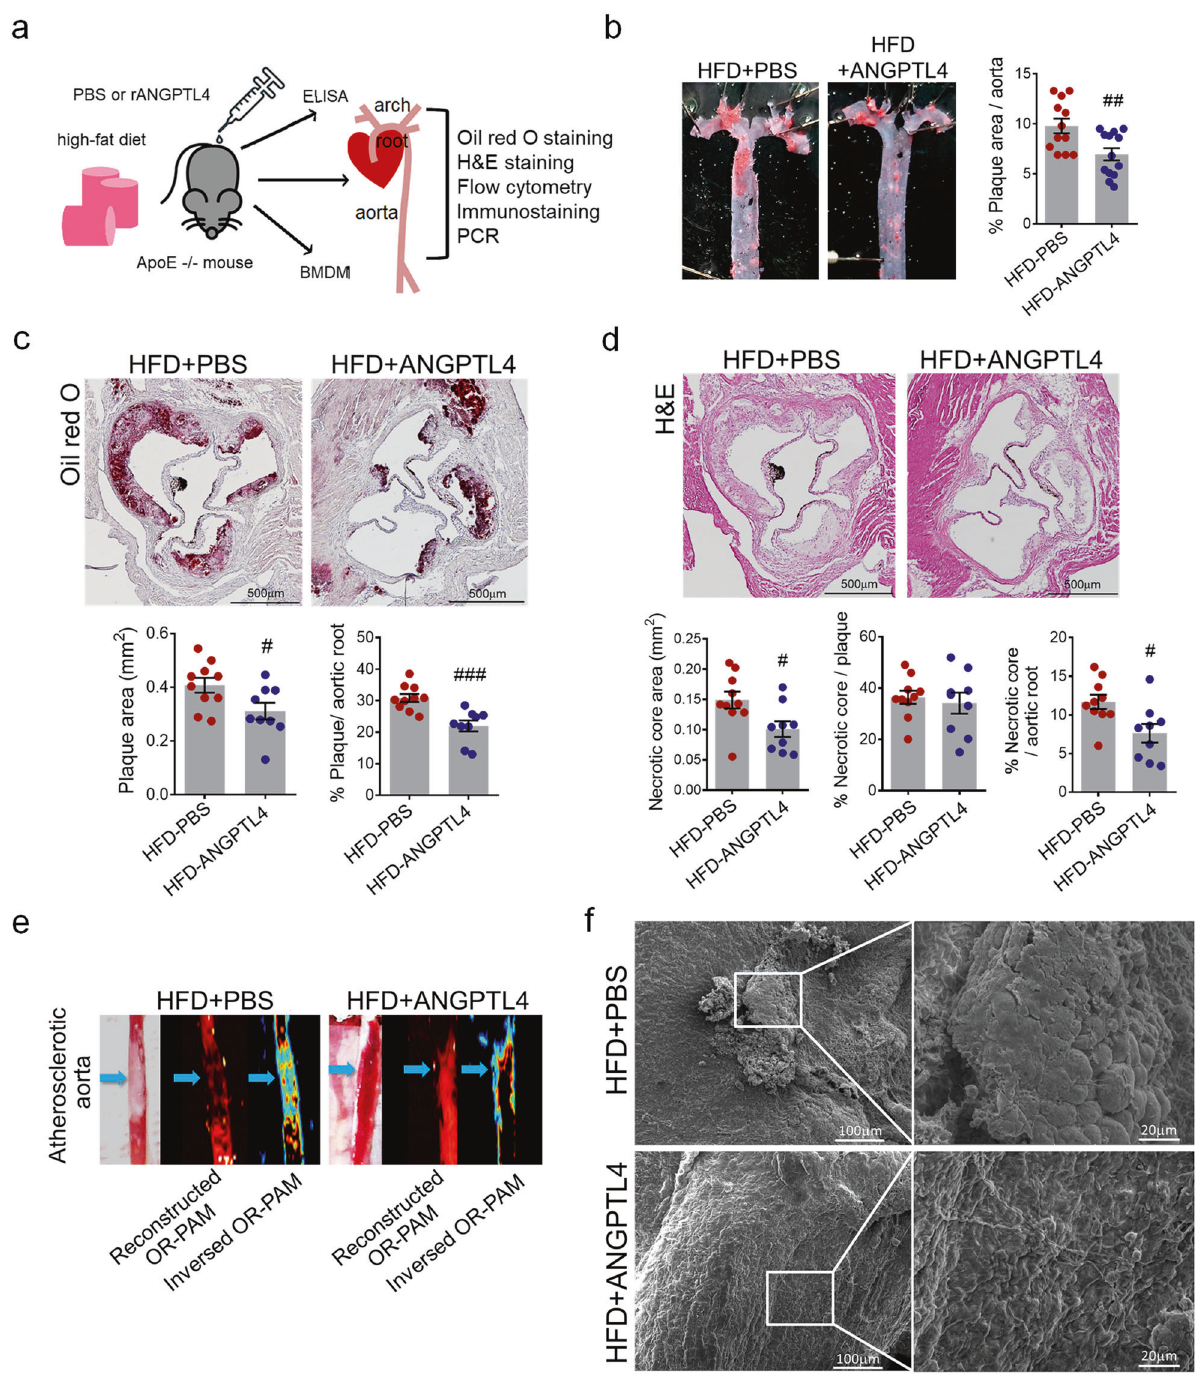
Fig. 1 Effects of ANGPTL4 administration on atherosclerotic progression in the atherosclerosis Apoe − / − mouse model. a Experimental scheme. Apoe − / − mice were fed a high-fat diet (HFD) with an injection of PBS or recombinant ANGPTL4 protein (2 μ g per mouse, intraperitoneally twice a week) for 8 weeks. Blood, BMDMs, aortic roots, and aortas were collected for further analyses. b Representative Oil red O-stained aortas from PBS-injected and ANGPTL4-injected Apoe − / − mice fed an HFD for 8 weeks. The relative atherosclerotic plaque area was quanti fi ed. c , Lesion area measured in Oil red O-stained cross sections of the aortic roots from the PBS and ANGPTL4 groups. The plaque area was measured and quanti fi ed as the relative size of the plaque to the aortic area. Scale bar, 500 μ m. d Representative images are shown for H&E-stained aortic roots from the PBS and ANGPTL4 groups. The necrotic core area, quali fi ed by the anucleated area, was measured and quanti fi ed as the relative size of the necrotic core to the plaque or aortic root. Scale bar, 500 μ m. e Representative images of atherosclerotic aortas were obtained using high-resolution optical resolution photoacoustic microscopy (OR-PAM). Blue arrows indicate atherosclerotic plaques. f Scanning electron microscope images showing the aorta surface isolated from the PBS and ANGPTL4 groups. Boxed areas on the aortic surface depict atherosclerotic plaques at higher magni fi cation. Scale bar, 20 μ m. Data were presented as the mean ± SEM. # p < 0.05, ## p < 0.01, ### p < 0.001 (by Student ’ s t